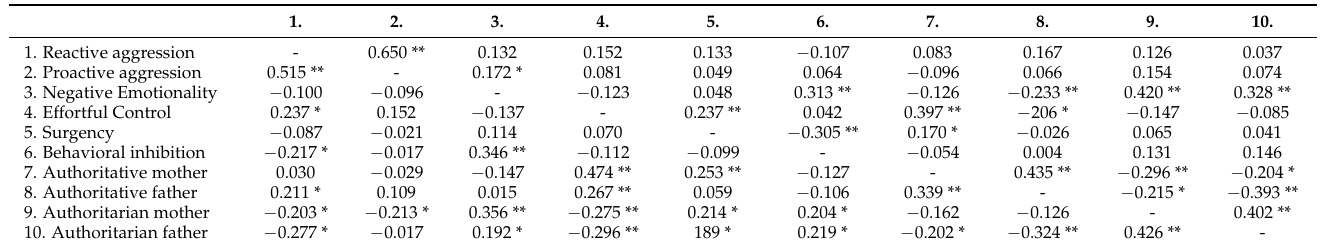
Table 2. Correlations between aggressive behavior, parenting styles and temperament variables (boys above and girls